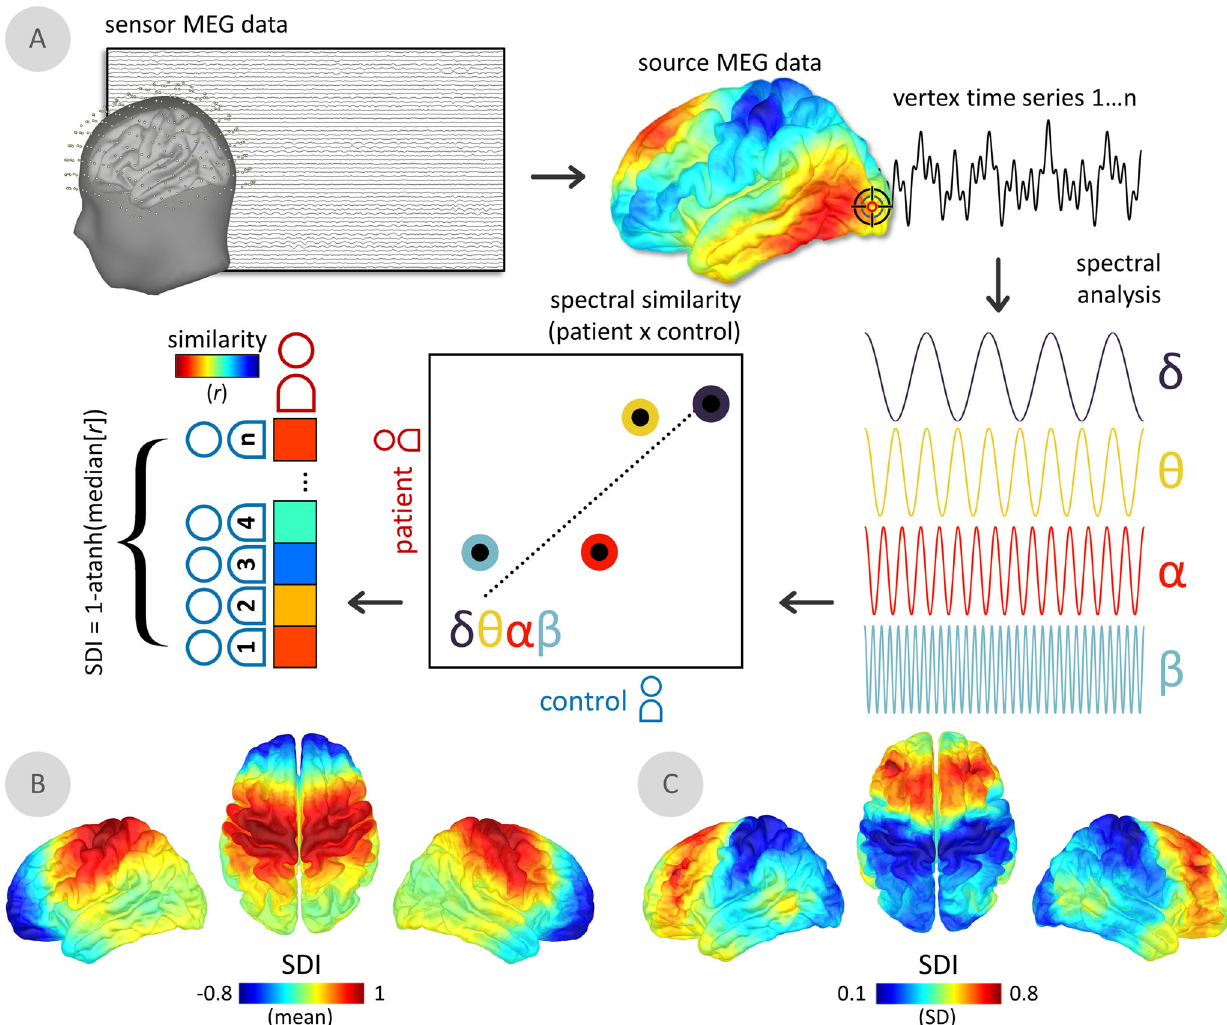
Fig. 2 The spectral deviation index (SDI). A For all participants, magnetoencephalography (MEG) data were cortically mapped, frequency- transformed, and averaged over canonical frequency bands (i.e., δ /delta: 2 – 4 Hz; θ /theta: 4 – 7 Hz; α /alpha: 8 – 12 Hz; β /beta: 15 – 29 Hz). Pearson correlation coef fi cients were then estimated at each vertex, representing the similarity across frequency-wise power estimates between each patient and control. For each patient, the median of these values was taken over all comparisons to control participants, which was then Fisher-transformed to ensure linear scaling (i.e., transformed with the inverse hyperbolic tangent function) and subtracted from 1 to indicate relative deviations from the control group. Surface maps below indicate the mean ( B ) and standard deviation ( C ) of the spectral deviation maps across all patients with Parkinson ’ s